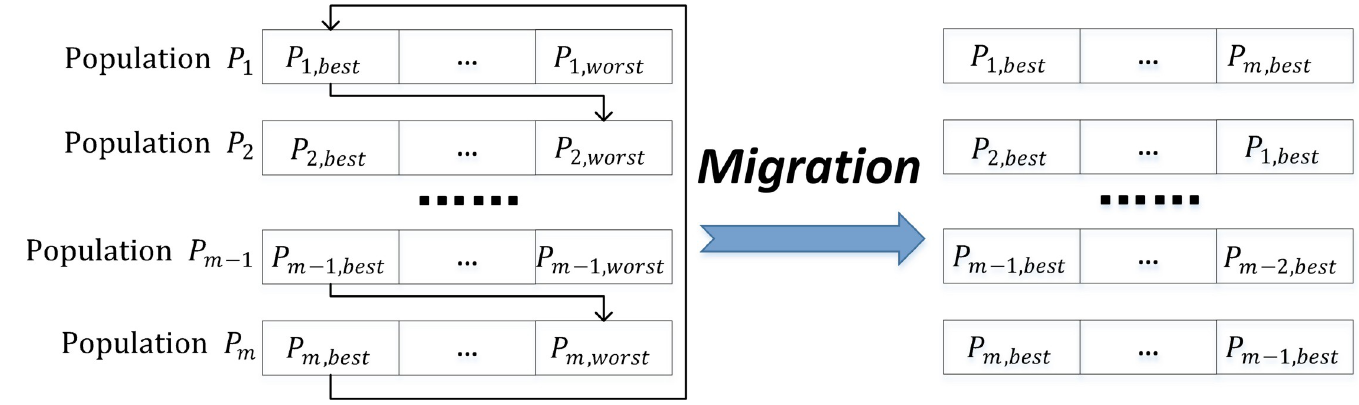
Fig 4. Best individuals migration between